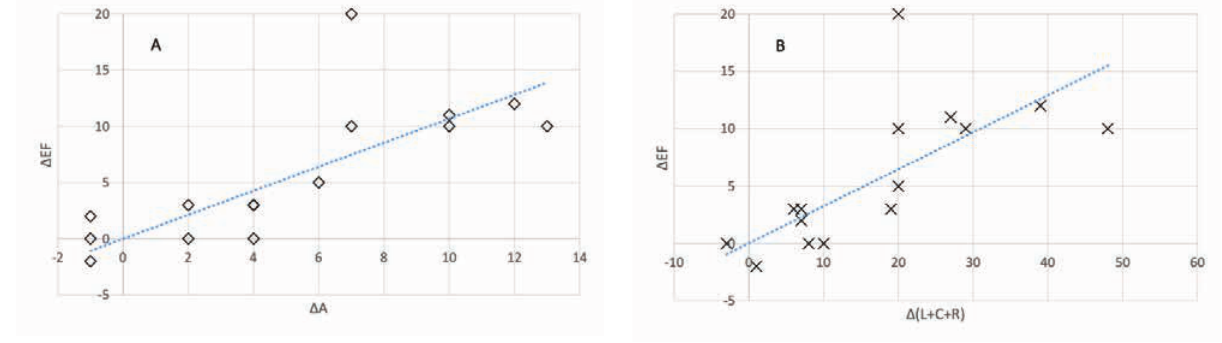
Figure 1: Improvement of the ejection fraction as a function of change in the area strain (A; p<0.001, Pearson coeff. 0.76) and sum of L+C+R strains (B; p<0.001, Pearson coeff.